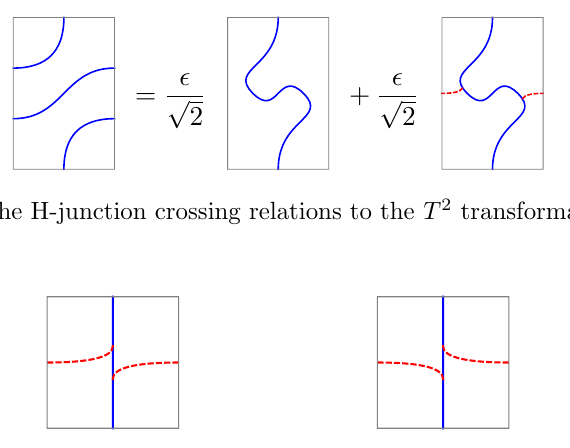
(cid:17) (cid:0) (left) and b